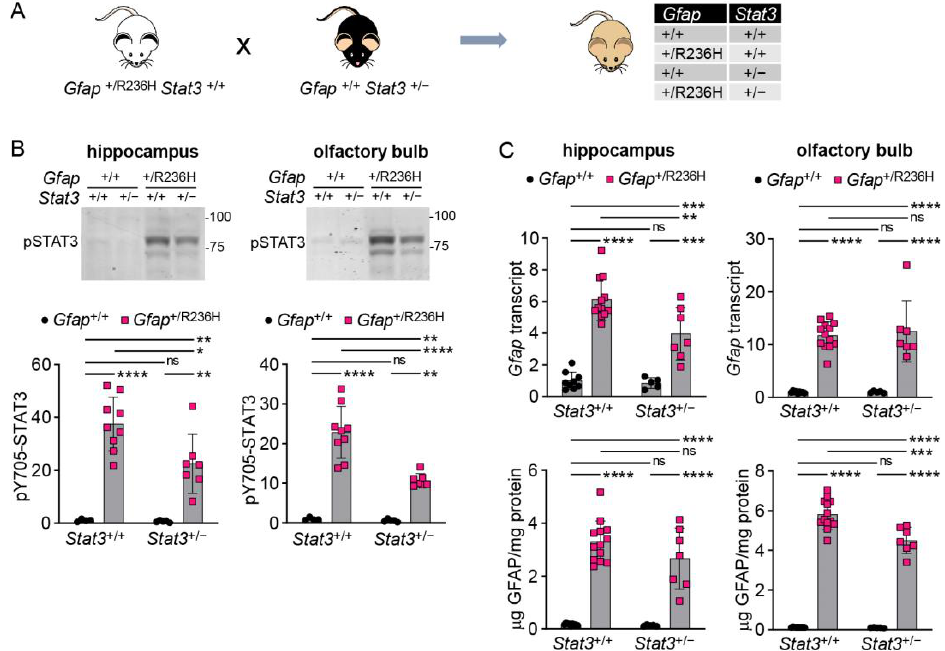
Figure 2. Genetic knockdown of Stat3 in AxD model mice has marginal effects on Gfap expression. ( A ) Genetic cross to generate Gfap +/R236H mice with reduced STAT3 activation. ( B , C ) Quantitation of pY705-STAT3 by immunoblotting ( B ), and Gfap transcript by qPCR and protein by ELISA ( C ) in olfactory bulb and hippocampus from Gfap +/R236H mice and Gfap +/+ littermate controls with het- erozygous knockout of the STAT3-Y705 phosphorylation site. Values represent fold change relative to the average for Gfap +/+ ; Stat3 +/+ mice. FVBB6F1 male and female mice were used at 12 weeks of age. Two-way ANOVA with Sidak’s post-tests, * p < 0.05, ** p < 0.01, *** p < 0.001, **** p <